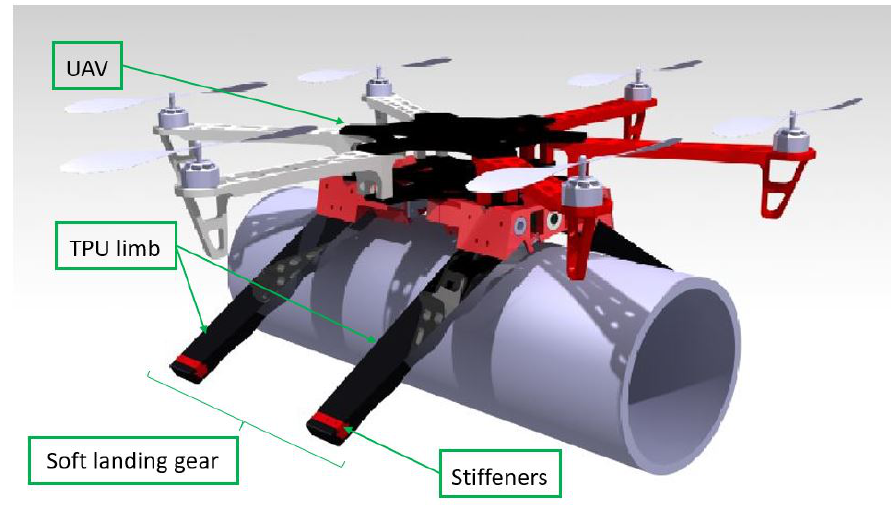
Figure 1. CAD design of the complete